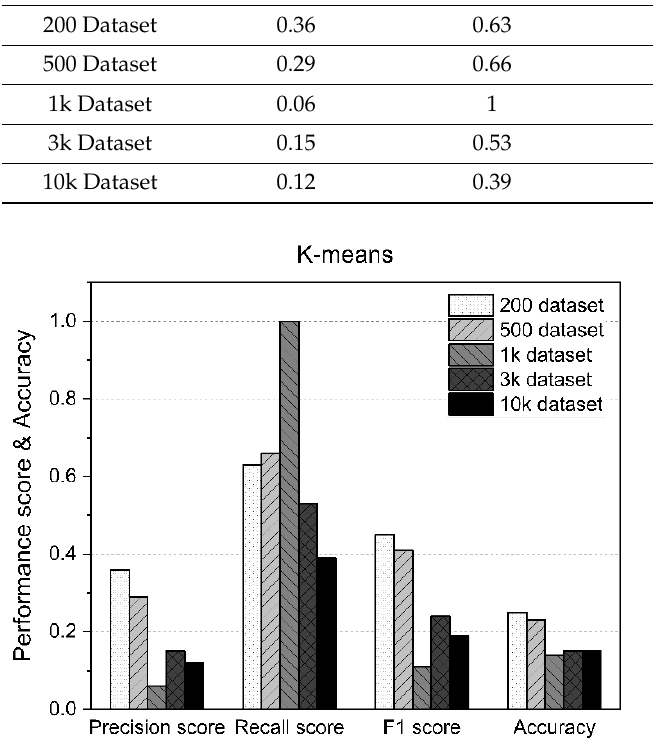
Figure 9. K-means performance results according to the size of the dataset.